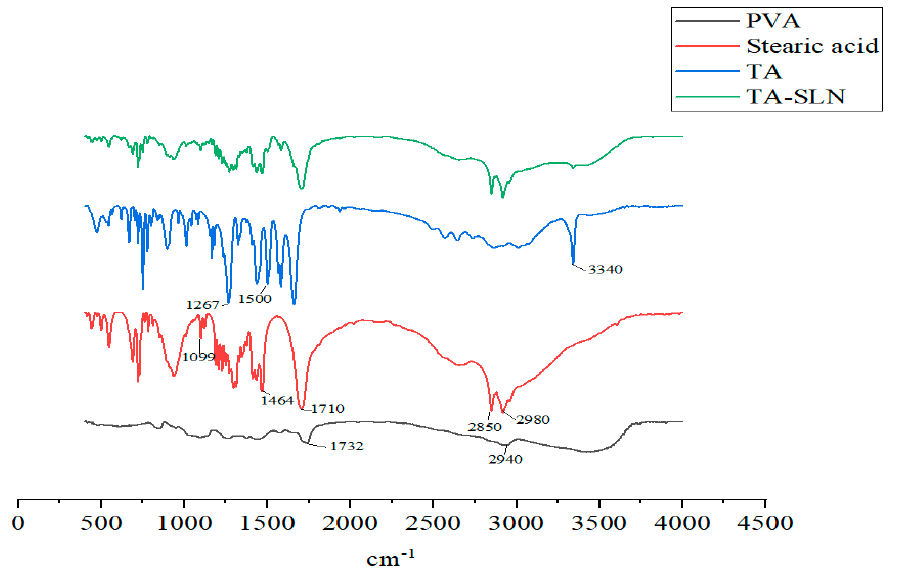
Figure 5. FT-IR analysis of PVA, stearic acid, TA and TA − SLN.